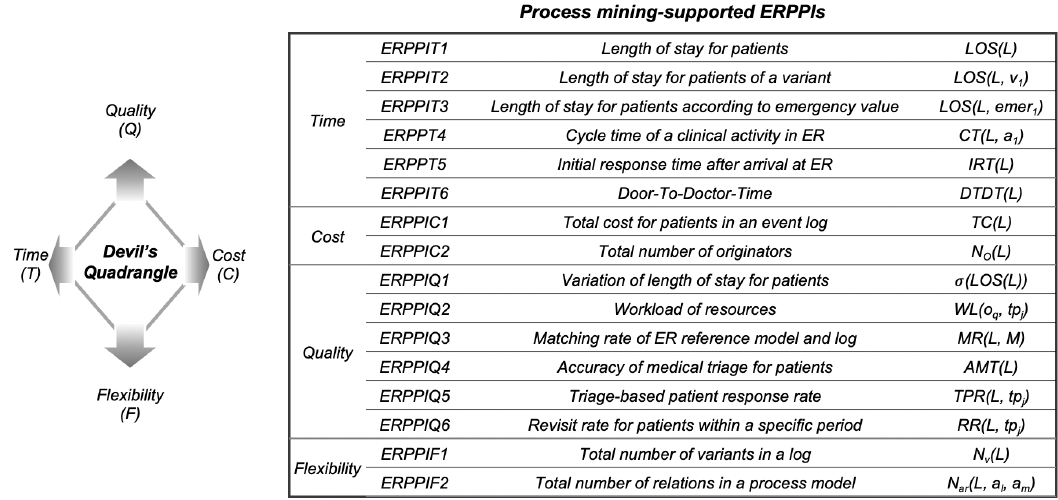
Figure 1. Overview of the proposed